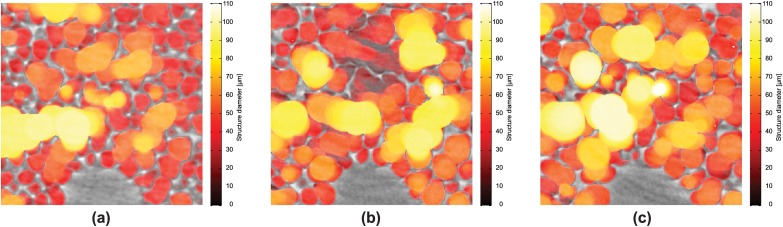
Structure diameters.Structure diameters obtained by air volume thickness map calculation with the 1.1 μm-pixel-size optics for three different peak inspiritory pressures: (a) 5 cmH2O; (b) 10 cmH2O; (c) 25 cmH2O.